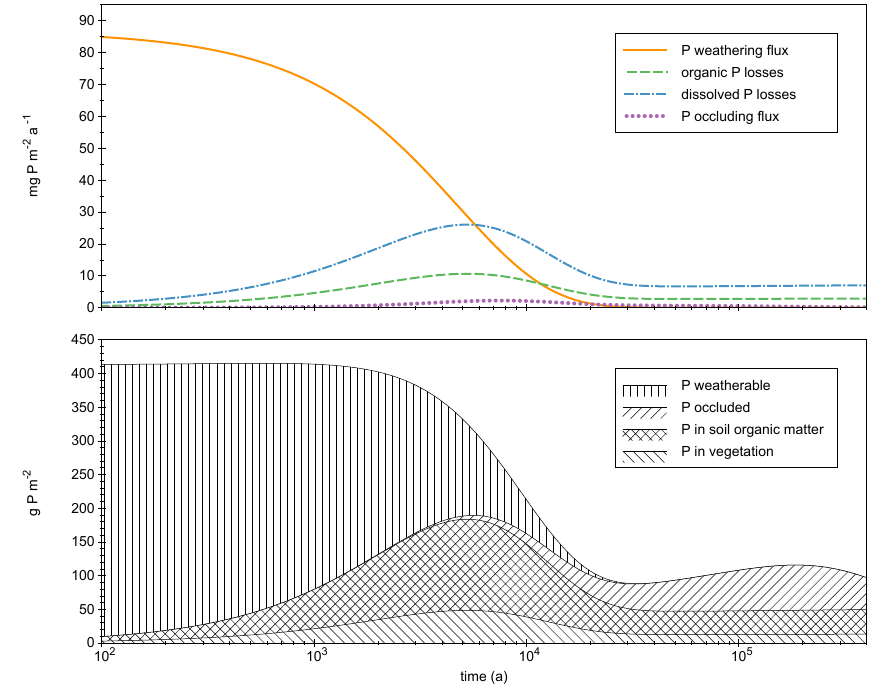
Fig. 5. Modeled phosphorus dynamics for the Franz Josef chronosequence. This simulation uses the climate and atmospheric input for the Franz Josef, found in Tables 2 and 3. The upper figure shows the evolution of the fluxes as the soil is formed, and the lower figure shows the evolution of the P pools. The evolution of the soil pools is comparable to Walker and Syers (1976) Franz Josef chronosequence data. Note that the x-axis is plotted on a logarithmic